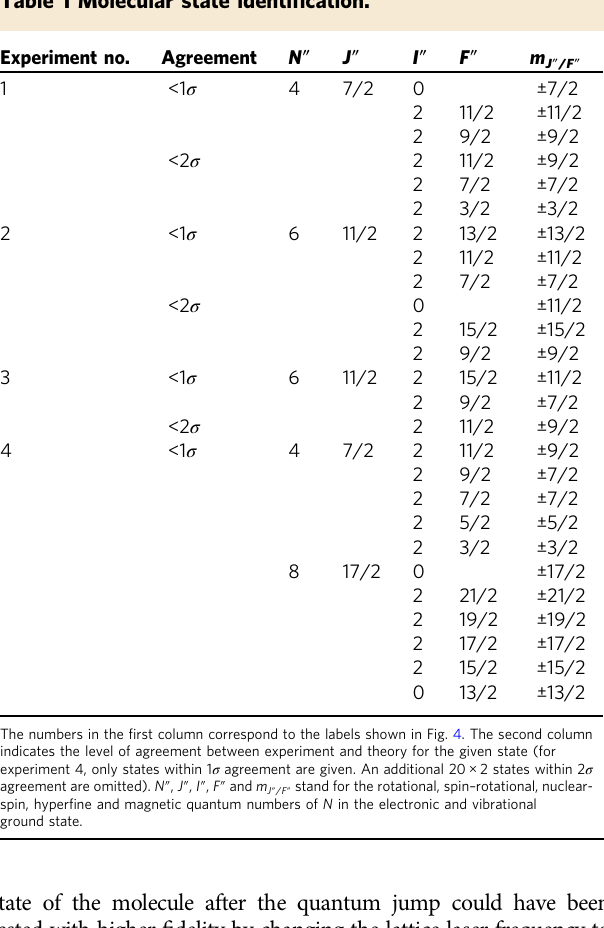
Table 1 Molecular state identi fi cation. Experiment no.